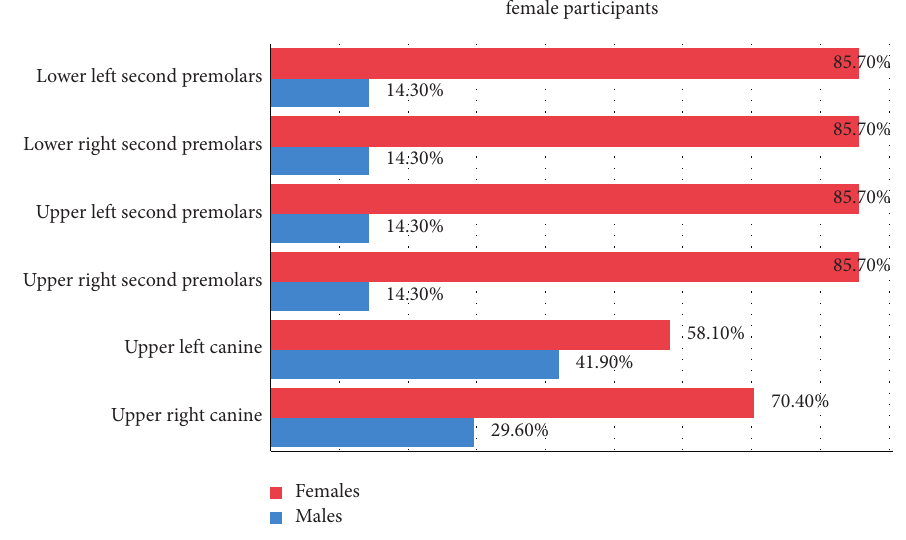
Figure 2: Gender distribution of most common impactions among study participants. Table 3: Gender distribution of spaces occupied among study participants.